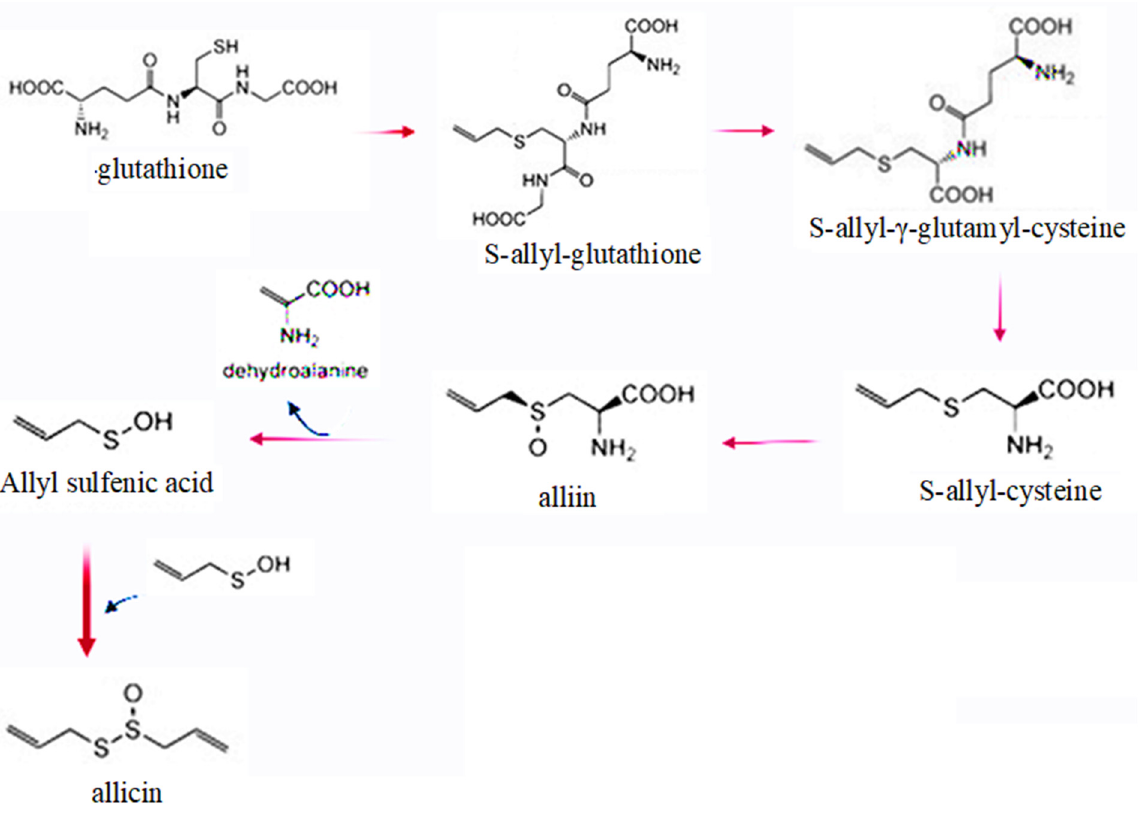
Figure 2. A schematic overview of allicin biosynthesis.